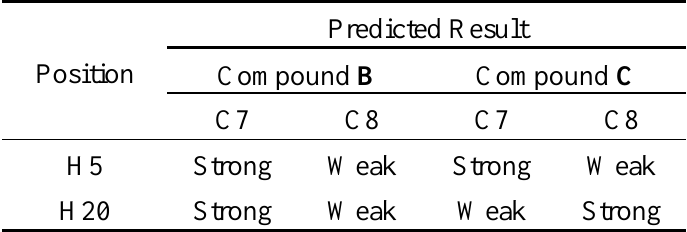
Table 2. Predicted HMBC Peak Intensities for Compounds B and